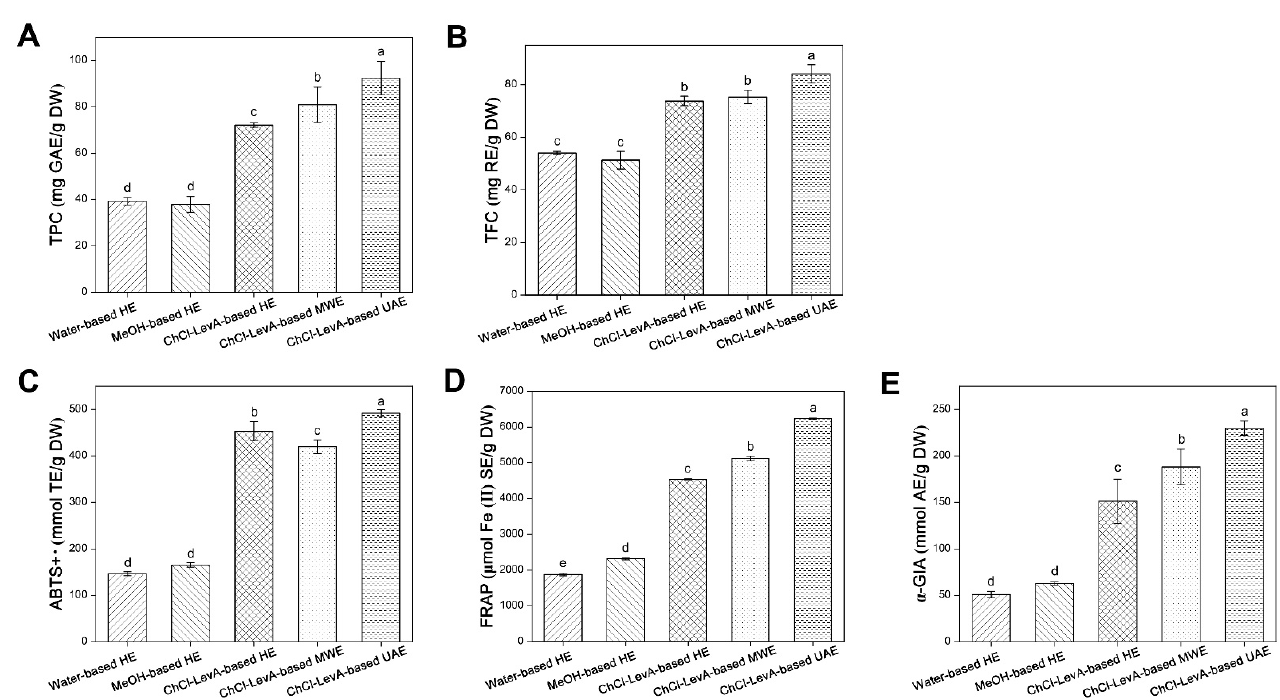
Figure 4. ( A ) TPC, ( B ) TFC, ( C ) ABTS + • scavenging activity, ( D ) FRAP assays, ( E ) α -glucosidase ( α -GIA) inhibitory activity in the DLT extracts extracted by different methods, where different lowercase letters indicate significant differences.